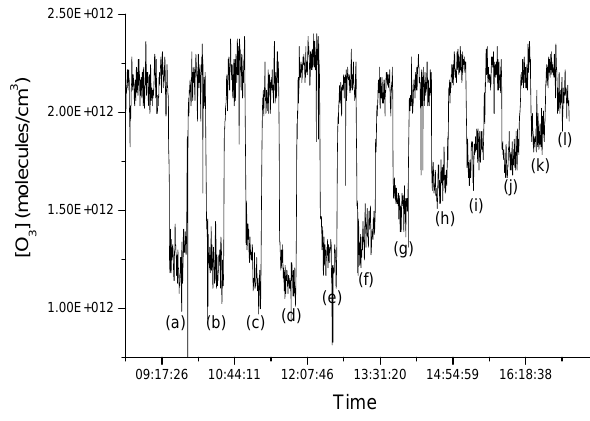
Fig. 4. Experimental profile of the O 3 concentration in presence of Figure 4. lauric acid (C 12 ) for different coating temperatures in the evaporator ( (a) without coating, (b) T = 23 . 6 ◦ C, (c) T = 30 ◦ C, (d) T = 40 ◦ C, (e) T = 50 ◦ C, (f) T = 60 ◦ C, (g) T = 65 ◦ C, (h) T = 68 ◦ C, (i) T = 72 ◦ C, (j) T = 75 ◦ C, (k) T = 80 ◦ C, (l) T = 90 ◦ C).